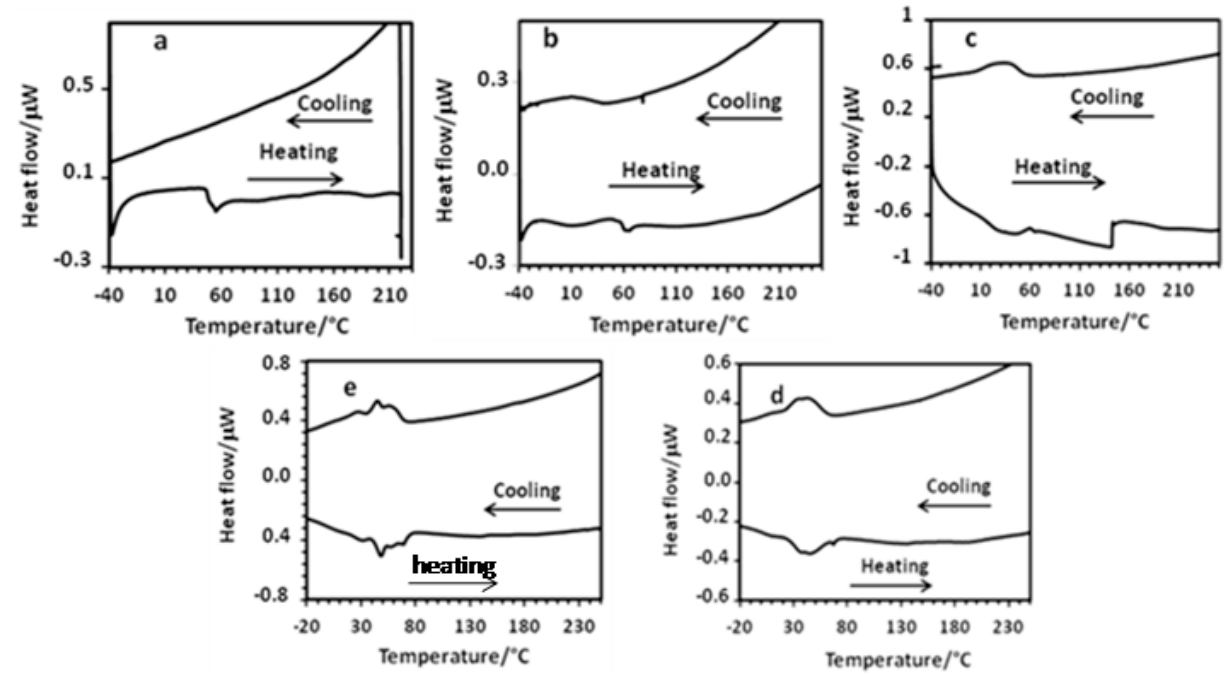
Figure 6. DSC traces of the second thermal cycle recorded under N 2 (5 °C min −1 ) for